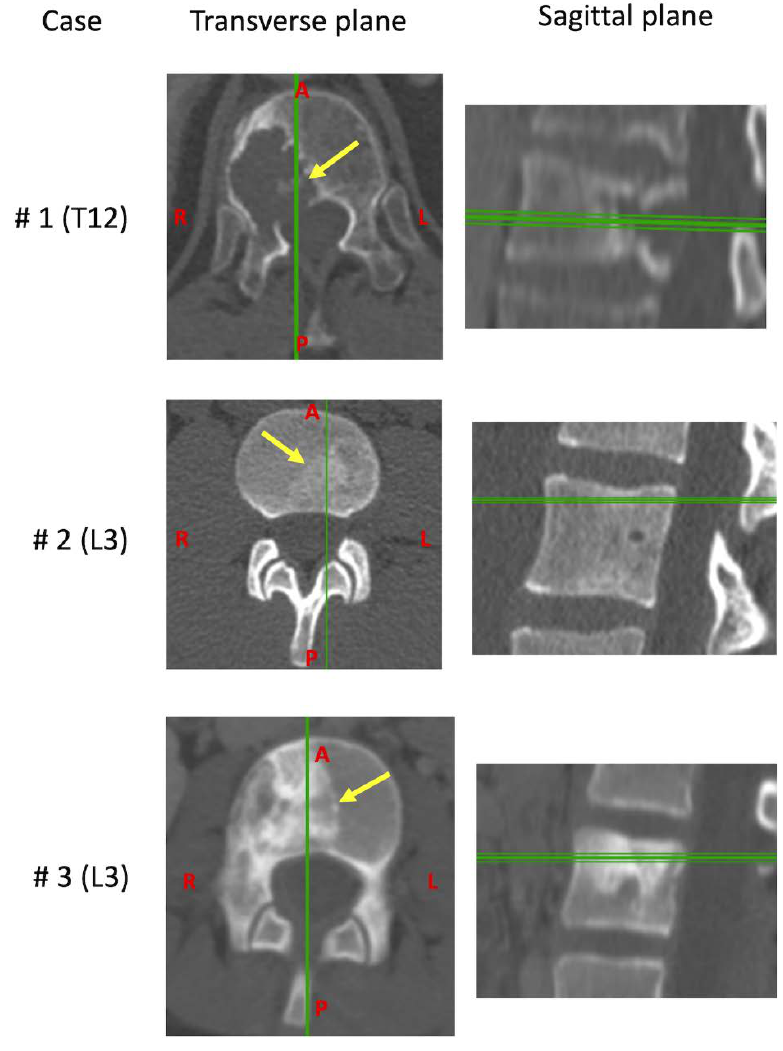
Figure 2. Transverse and sagittal planes of the CT scans for each vertebra before the resection. The arrows indicate the position of the tumor, the vertical and horizontal lines indicate the relative position of the plans.